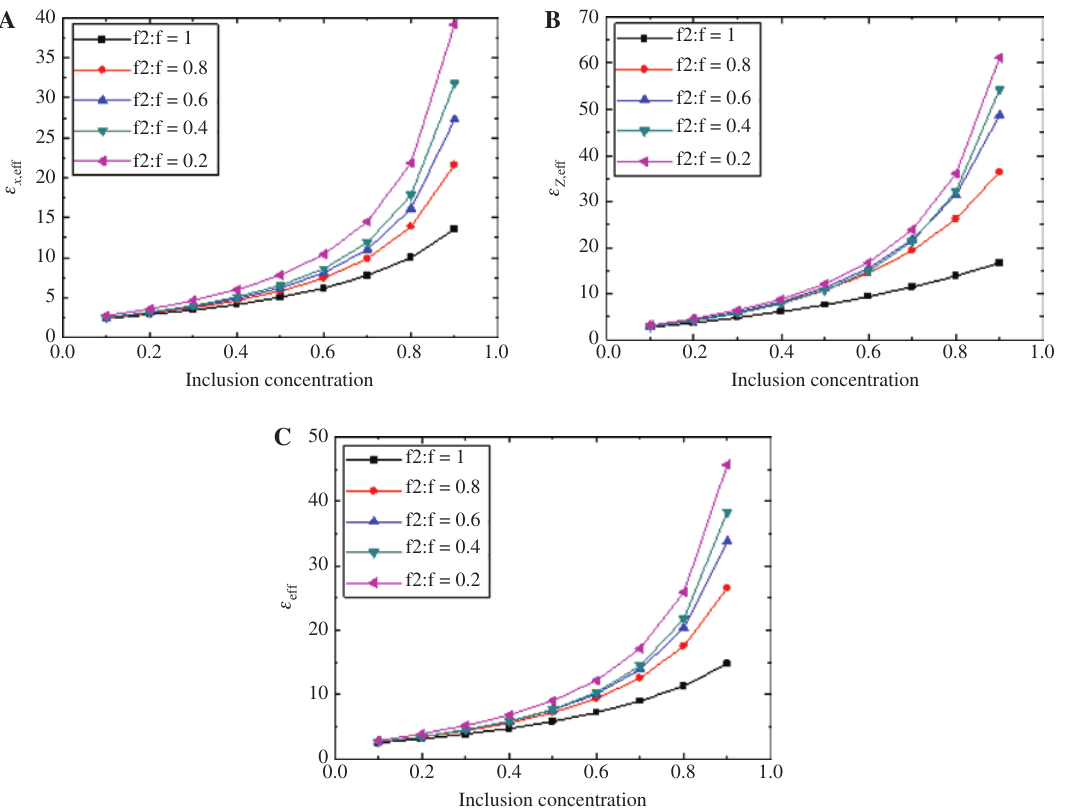
Figure 5: The effective permittivity of a mixture with aligned bilayer ellipsoids in the x or y direction (A) and z direction (B), along with that of a mixture with bilayer ellipsoids oriented randomly (C) for different inclusion